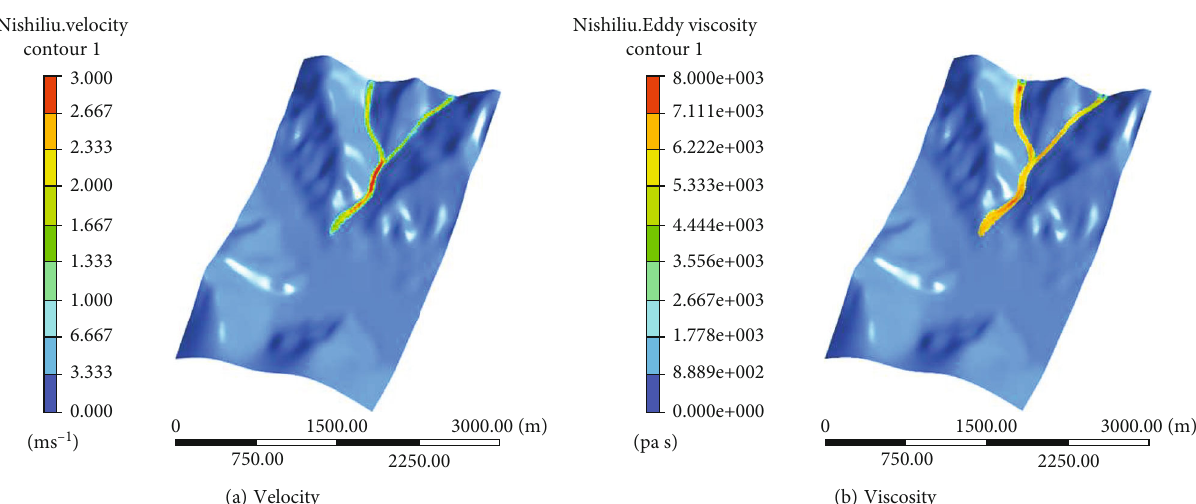
Figure 5: Velocity and viscosity contour on free surface between debris fl ow and air (inlet speed equals to